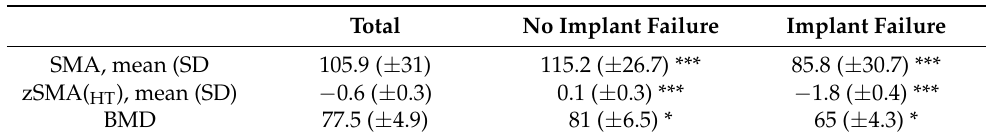
Table 3. Results of skeletal muscle area (SMA), bone mineral density (BMD) and implant failure. * p ≤ 0.05, *** p ≤